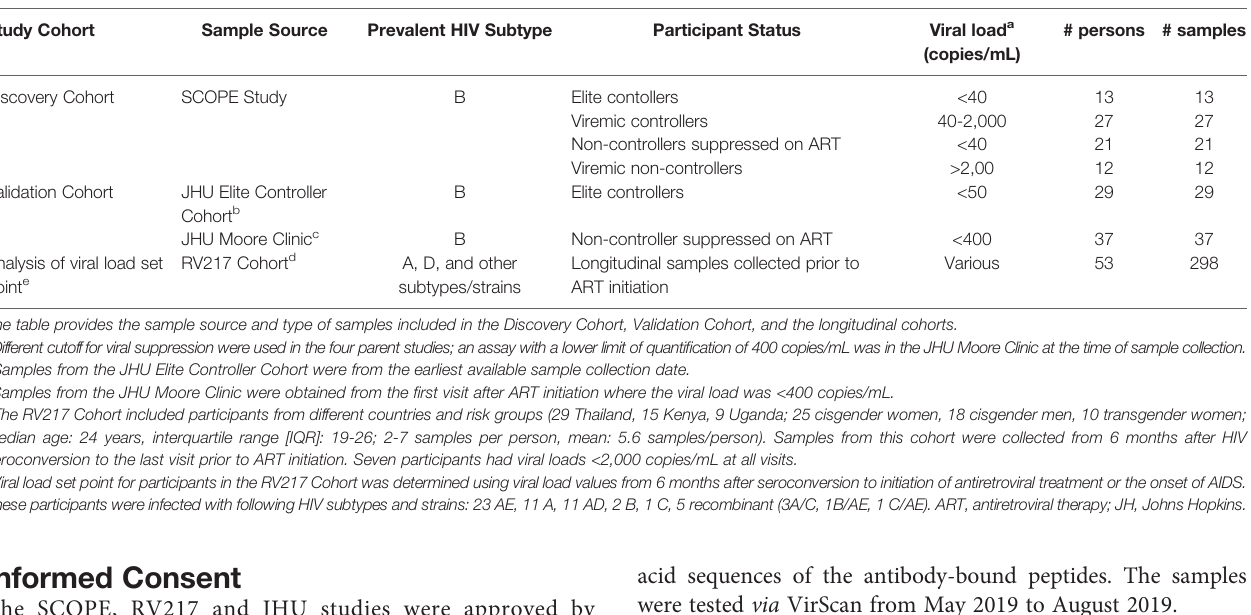
TABLE 1 | Samples used for